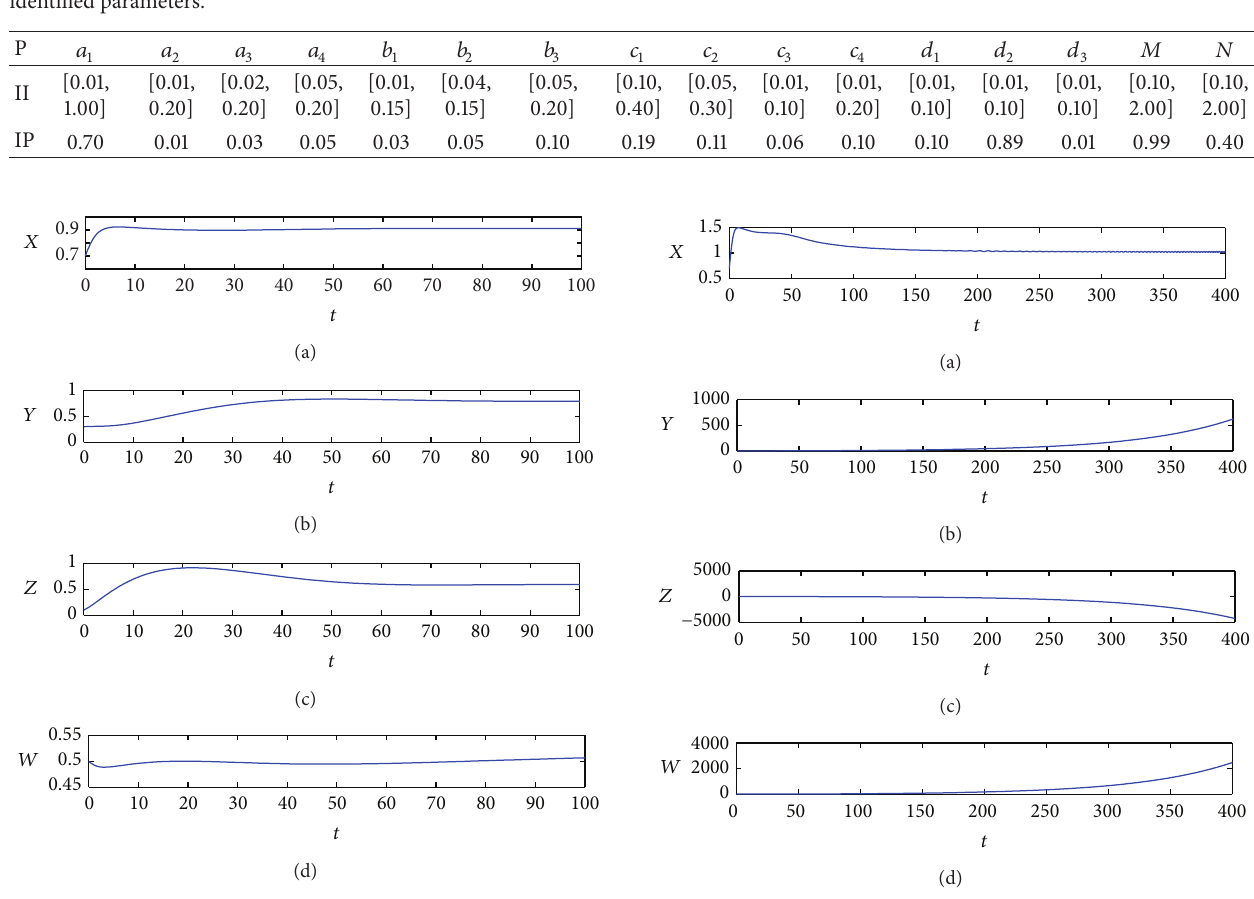
Figure 6: The time series of 𝑋(𝑡),𝑌(𝑡),𝑍(𝑡),𝑊(𝑡) .